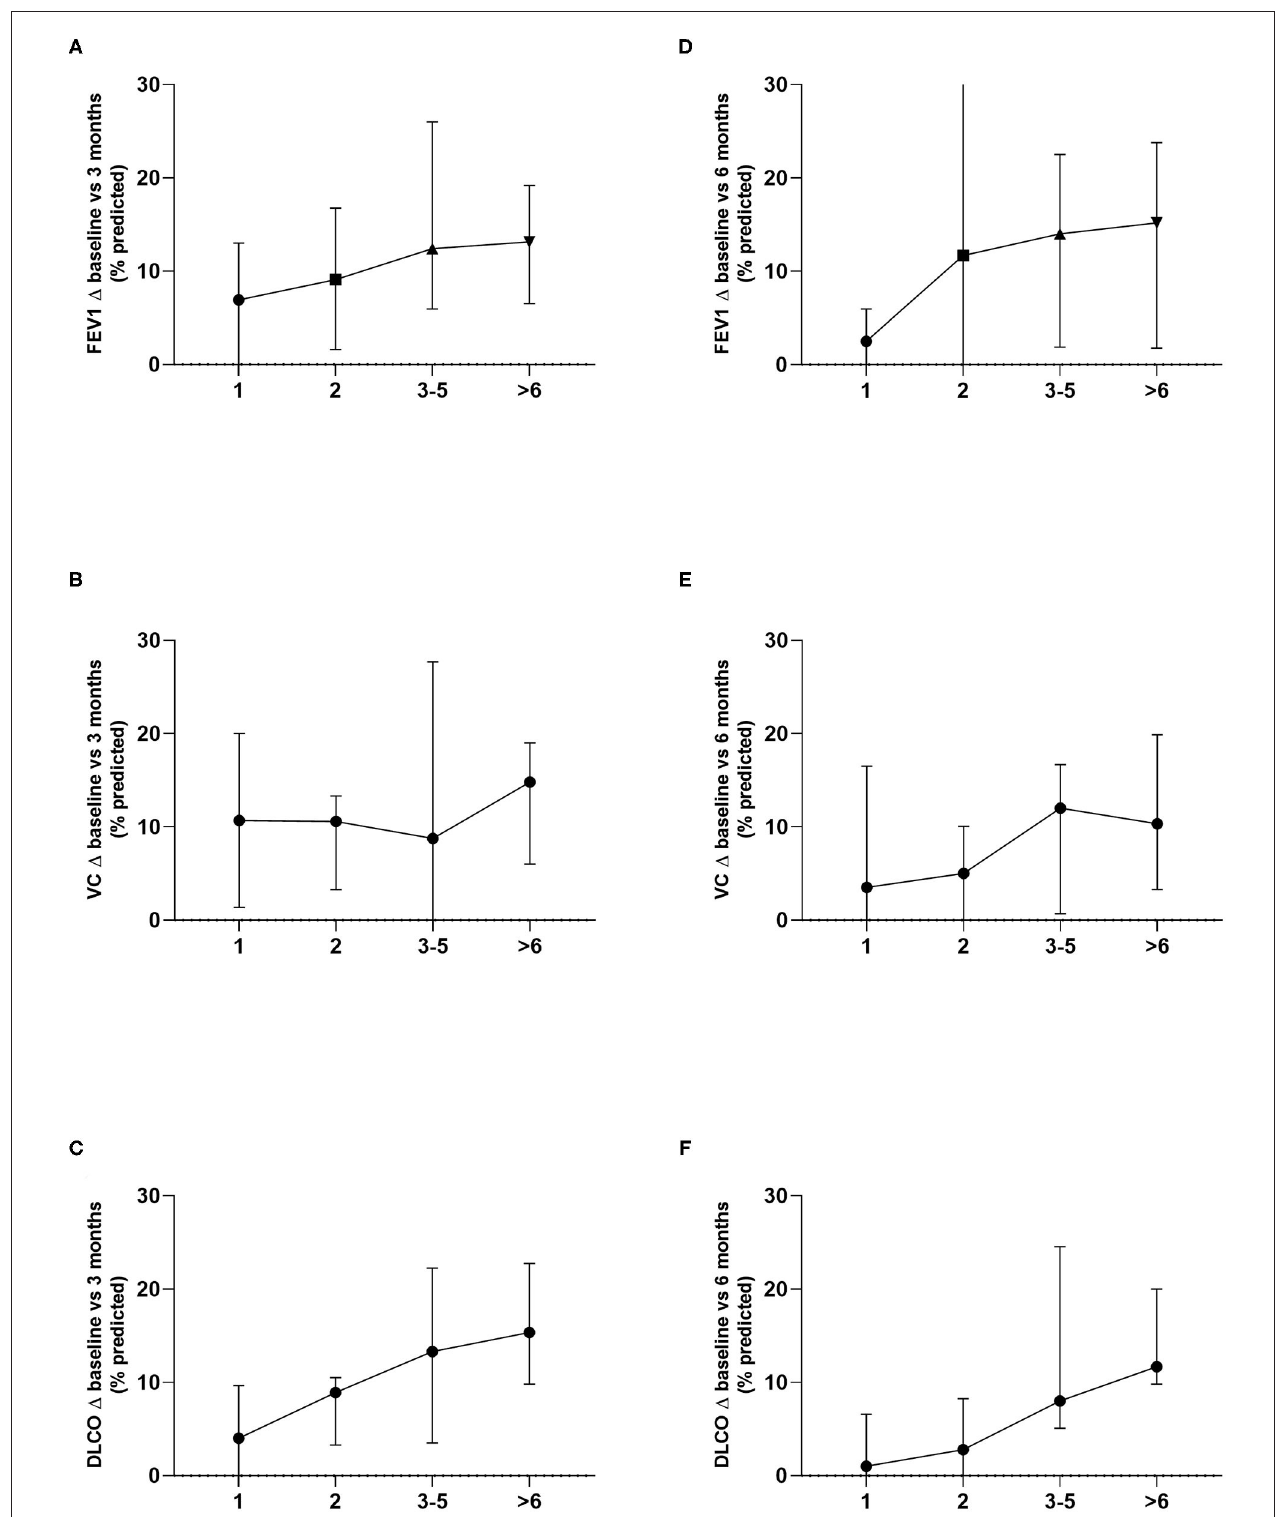
FIGURE 4 | Lung function changes in the different groups according to the number of resected metastases were analyzed. Differences in decline of DLCO were the greatest and showed a statistical trend at 3 months ( p = 0.06) and statistically significant differences at 6 months ( p = 0.01) (C, F) . FEV1 (A, D) as well as VC (B, E) showed no statistically significant